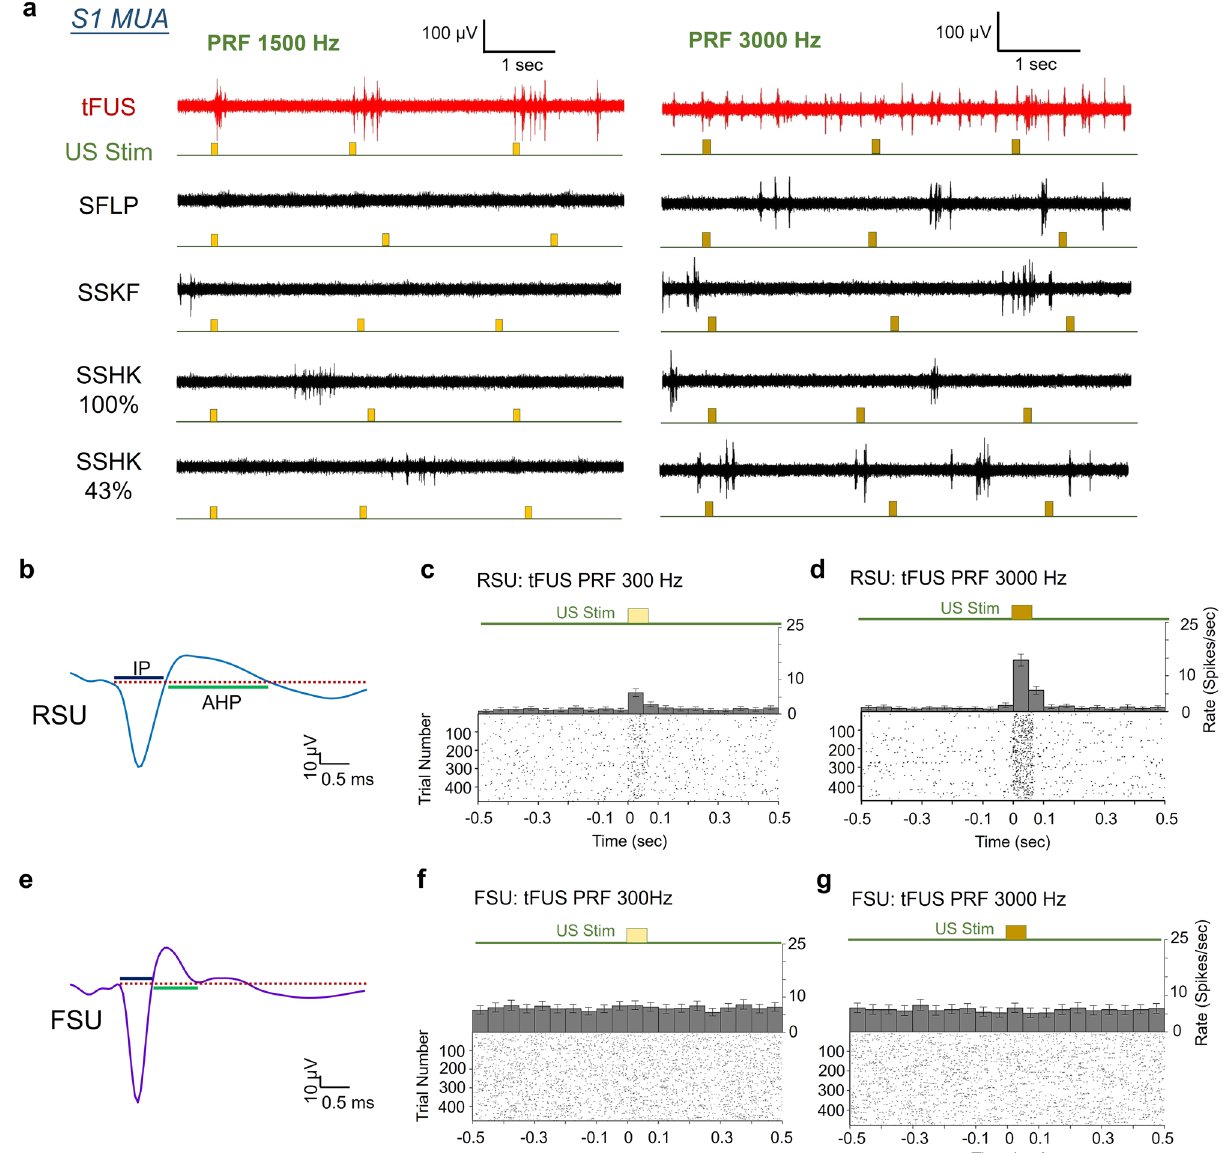
Fig. 3 The neuronal spiking activities in response to tFUS. a Examples of acquired multi-unit activity (MUA) from the S1 using tFUS with PRF = 1500 Hz (left) and PRF = 3000 Hz (right) show time-locked activity during tFUS stimulation. The timing of the ultrasound-induced action potentials with respects to administered stimulations (the timing of ultrasound stimulation is added with 10% jittering presented below each MUA trace) are exempli fi ed with three trials. The sham conditions, i.e., SFLP, SSKF, SSHK 100% and SSHK 43% (see Methods for descriptions of SSHK levels) show disappearance of time-locked MUAs. These MUAs are obtained from the in vivo rats anesthetized with iso fl urane. b A typical example of a regular-spiking unit (RSU) separated from the recorded MUAs. The waveform features, i.e., time durations of initial phase (IP) and afterhyperpolarization (AHP) were extracted to conduct the units ’ separation. c , d Representative peri-stimulus time histograms (PSTHs, bin size: 50 ms, n = 478 trials for each time bin) and raster plots of one RSU (IP duration mean: 850 μ s; AHP duration mean: 1850 μ s) responding to the PRF of 300 Hz ( c ) and 3000 Hz ( d ). e An example of a fast-spiking unit (FSU) identi fi ed with short IP and AHP durations. f , g Representative PSTHs (bin size: 50 ms, n = 478 trials for each time bin) and spiking raster plots of one FSU (IP duration mean: 700 μ s; AHP duration mean: 600 μ s) in response to the two tFUS conditions with PRF of 300 Hz ( f ) and 3000 Hz ( g ), respectively. The time histograms and return plots of the inter-spike interval (ISpI) are depicted in Supplementary Figs. 4 and 5. All of the temporal dynamics were computed across 478 trials. The applied ultrasound conditions are described in Table 1 (see Methods). Data are shown as the mean ± 95% con fi dence interval in the PSTHs. c , d , f , g are example PSTHs from the same subject, same unit under tFUS stimulation at 300 Hz and 3000 Hz PRF. Source data are provided in the Source Data fi signi fi cantly altered by the levels of PRF, consistent with the case signi fi cant ( p > 0.5) when the rats were anesthetized with the studies (Fig. 3f, g and Supplementary Fig. 5a). Furthermore, the ketamine and xylazine, the PRF was still deemed as a signi fi cant interaction between the neuronal cell type, i.e., RSU/FSU, and the factor ( p = 0.042). PRF levels was further investigated using a two-way ANOVA. Although this interaction was not statistically